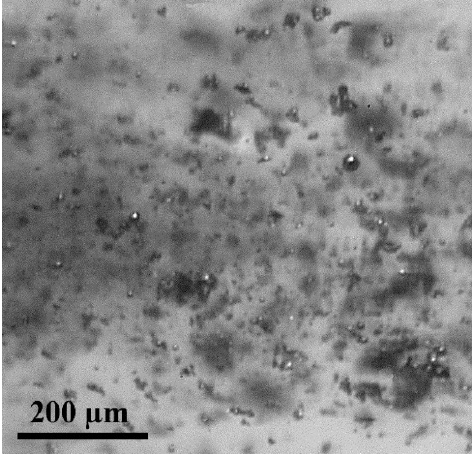
Figure 11. Closer view of the Fe fragments recovered in the gel presented in Figure 10b, after a 255 GPa laser shock, showing a mixture of solid debris of irregular shapes and perfectly spherical